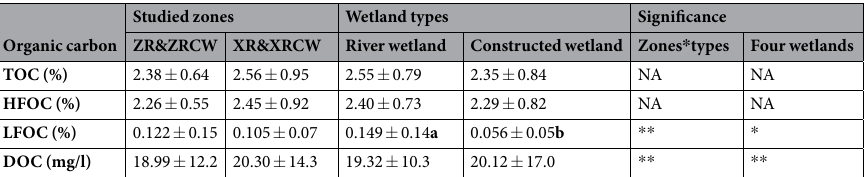
Table 1. Carbon contents and differences among the four wetlands (mean ± SD). NA: no significant difference, * : P < 0.05, ** : P < 0.01. Data with a and b show significant difference at α = 0.05 (Duncan